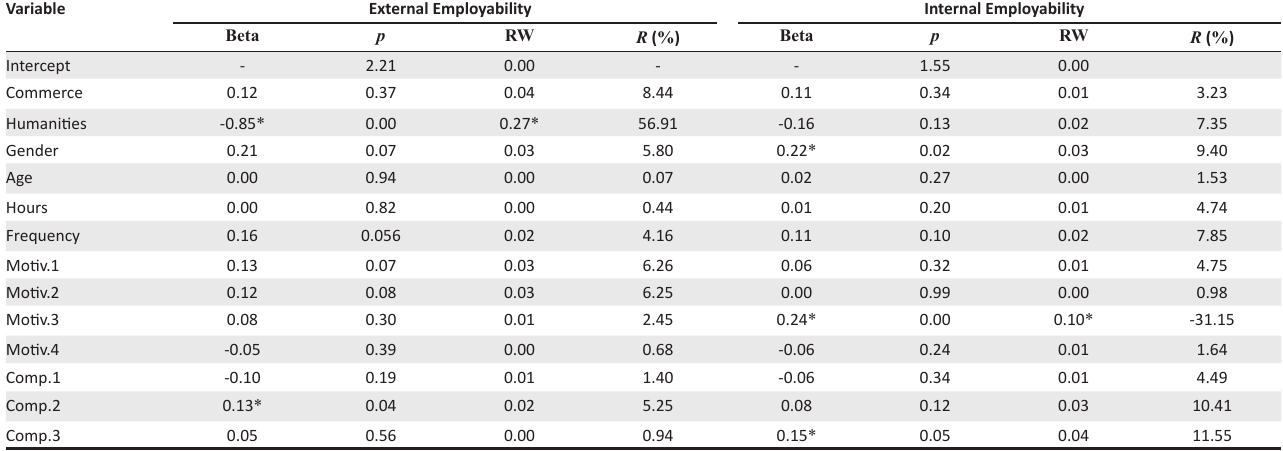
TABLE 5: Multiple Regression and Relative Weights Analysis Results for External and Internal Employability.